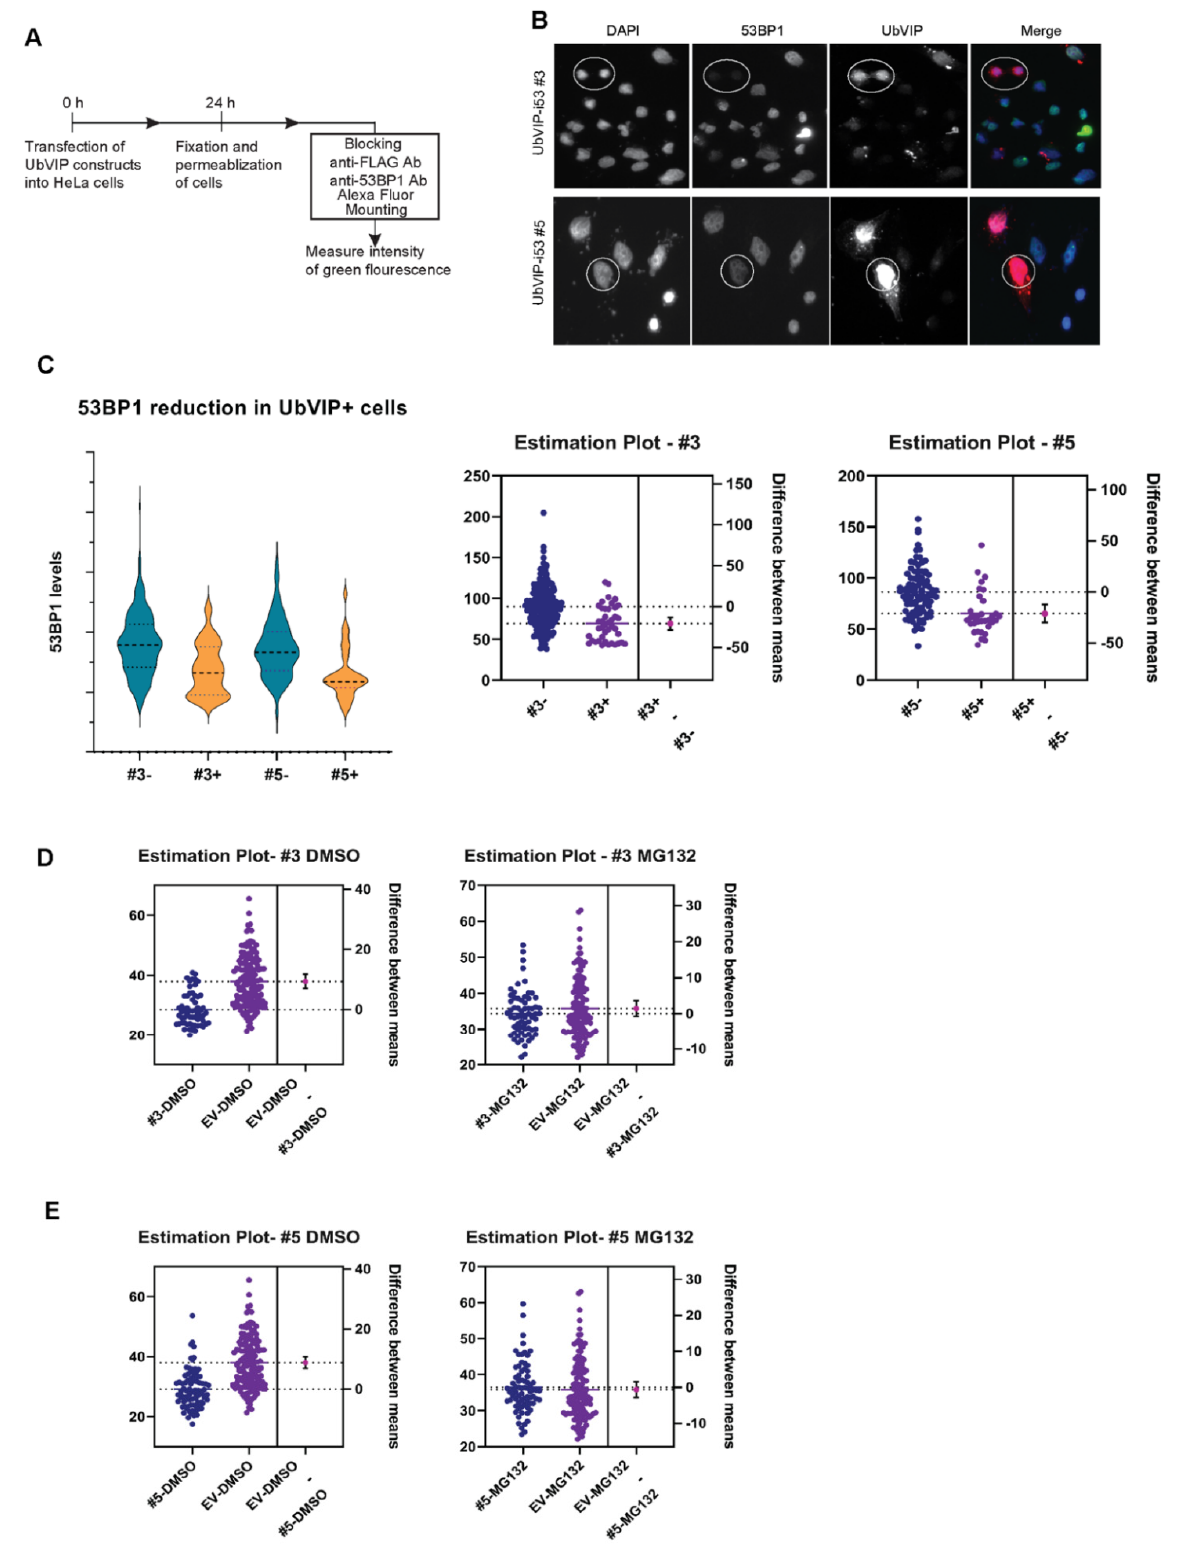
Figure 4. ( A ) Experimental outline for determining 53BP1 presence using immunofluorescent analysis of HeLa cells. HeLa cells were transfected with the UbVIP constructs and after 24 h, cells were fixed and stained with antibody against 53BP1 and FLAG tag. Cells were observed microscopically and intensity of 53BP1 fluorescence was measured. ( B ) Representative micrographs of cells transfected with